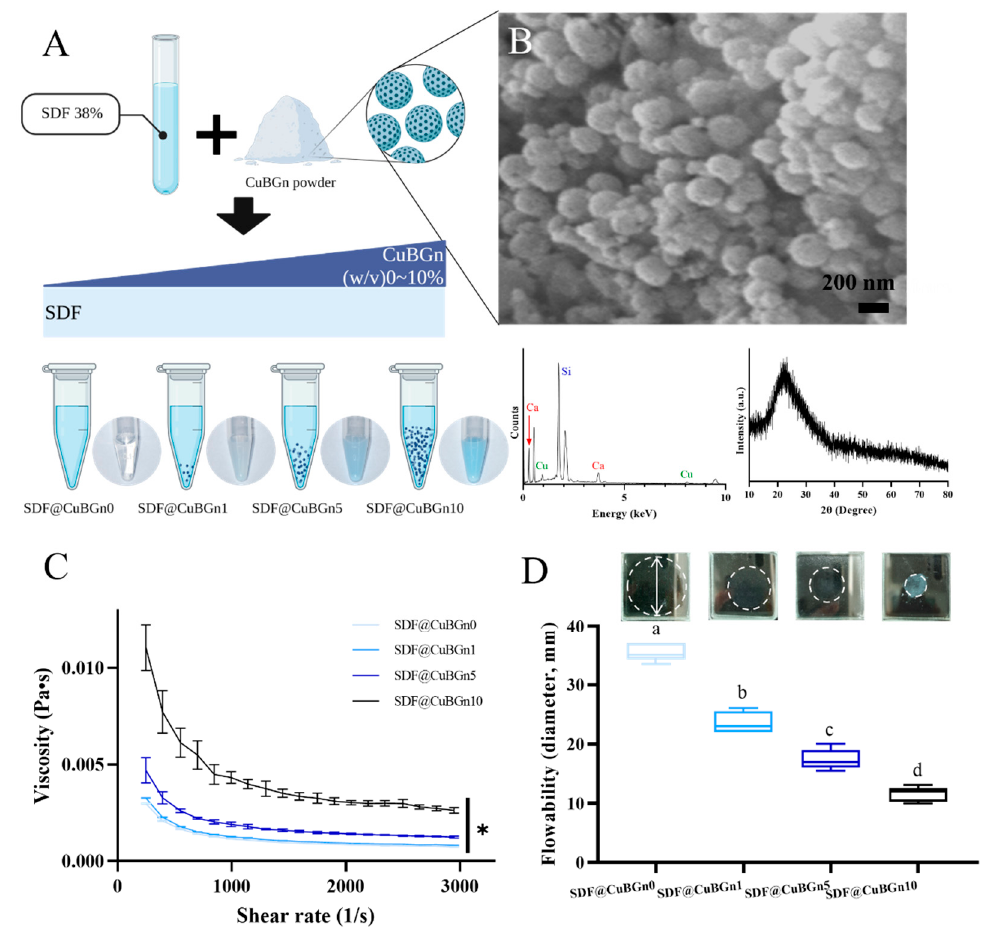
Figure 1. Preparation and characterization of copper ‐ doped bioactive glass nanoparticles (CuBGns) and physical analysis of a silver diamine fluoride (SDF) solution mixed with CuBGns (SDF@CuBGns). ( A ) Schematic illustration of the preparation of SDF@CuBGn and a picture of the actual mix. CuBGn was placed in SDF for 0, 1, 5, and 10 ( w / v )%, and the larger the amount of powder was, the